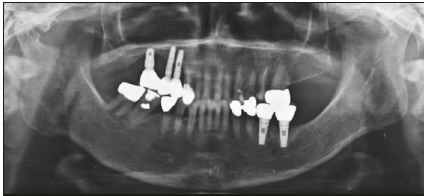
Figure 4: Postoperative radiographic view (panoramic X-ray image). Implant reinstallation on #37 region four months after the implant removal.